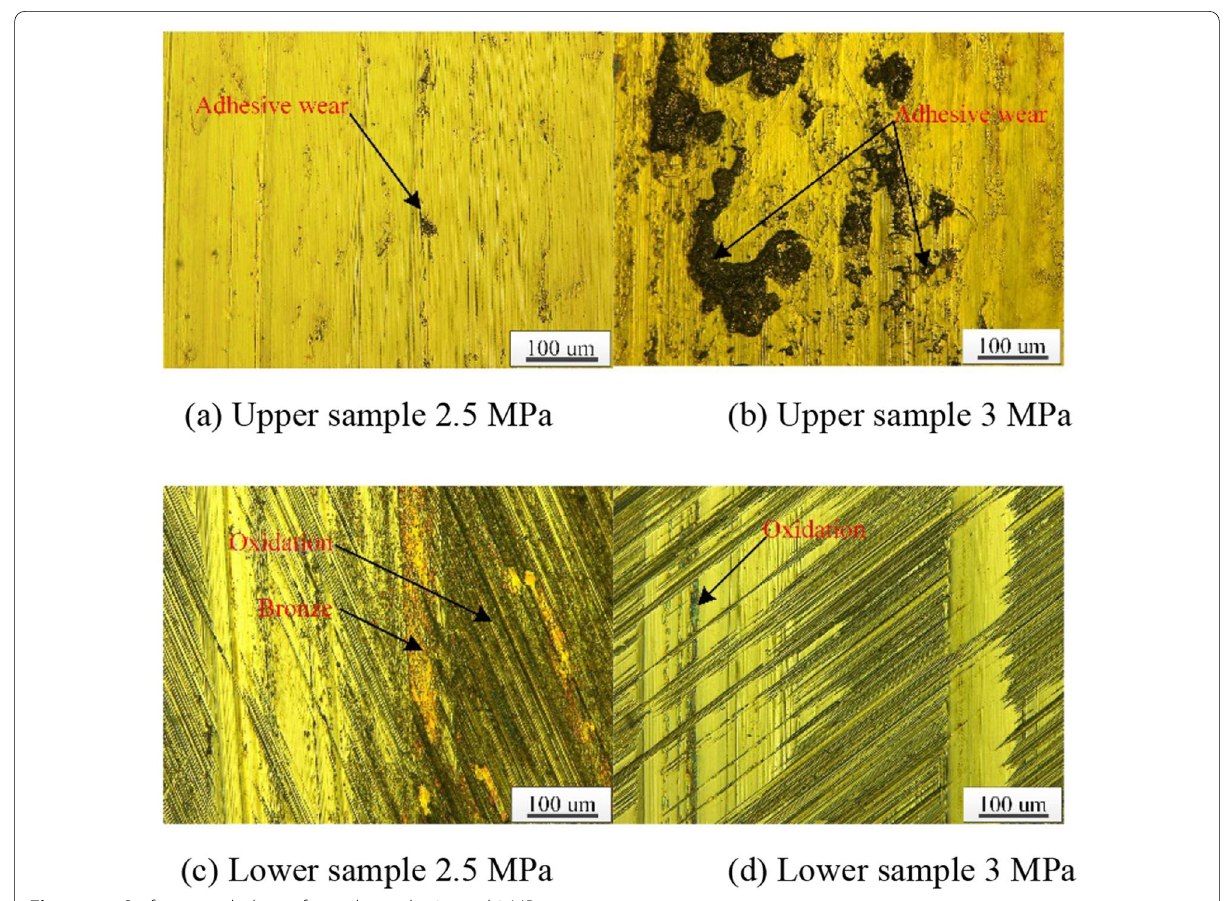
Figure 15 Surface morphology of samples under 2.5 and 3